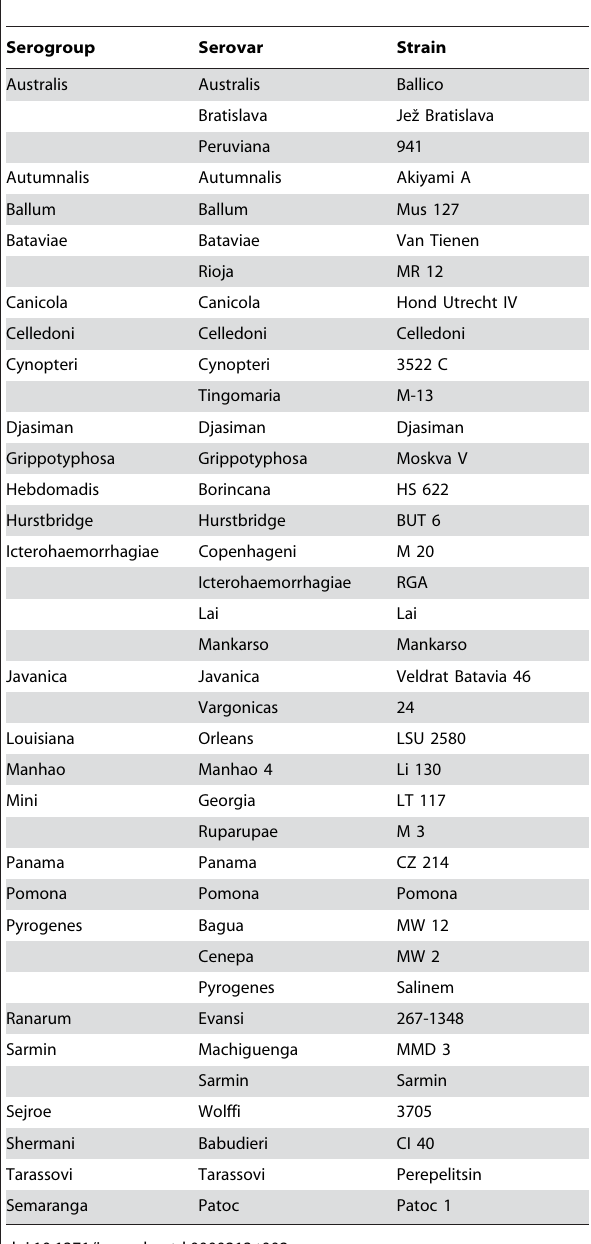
Table 2. Panel of Leptospiral Serogroup Antisera Used to Characterize ‘‘ Leptospira licerasiae ’’ strain VAR10 T